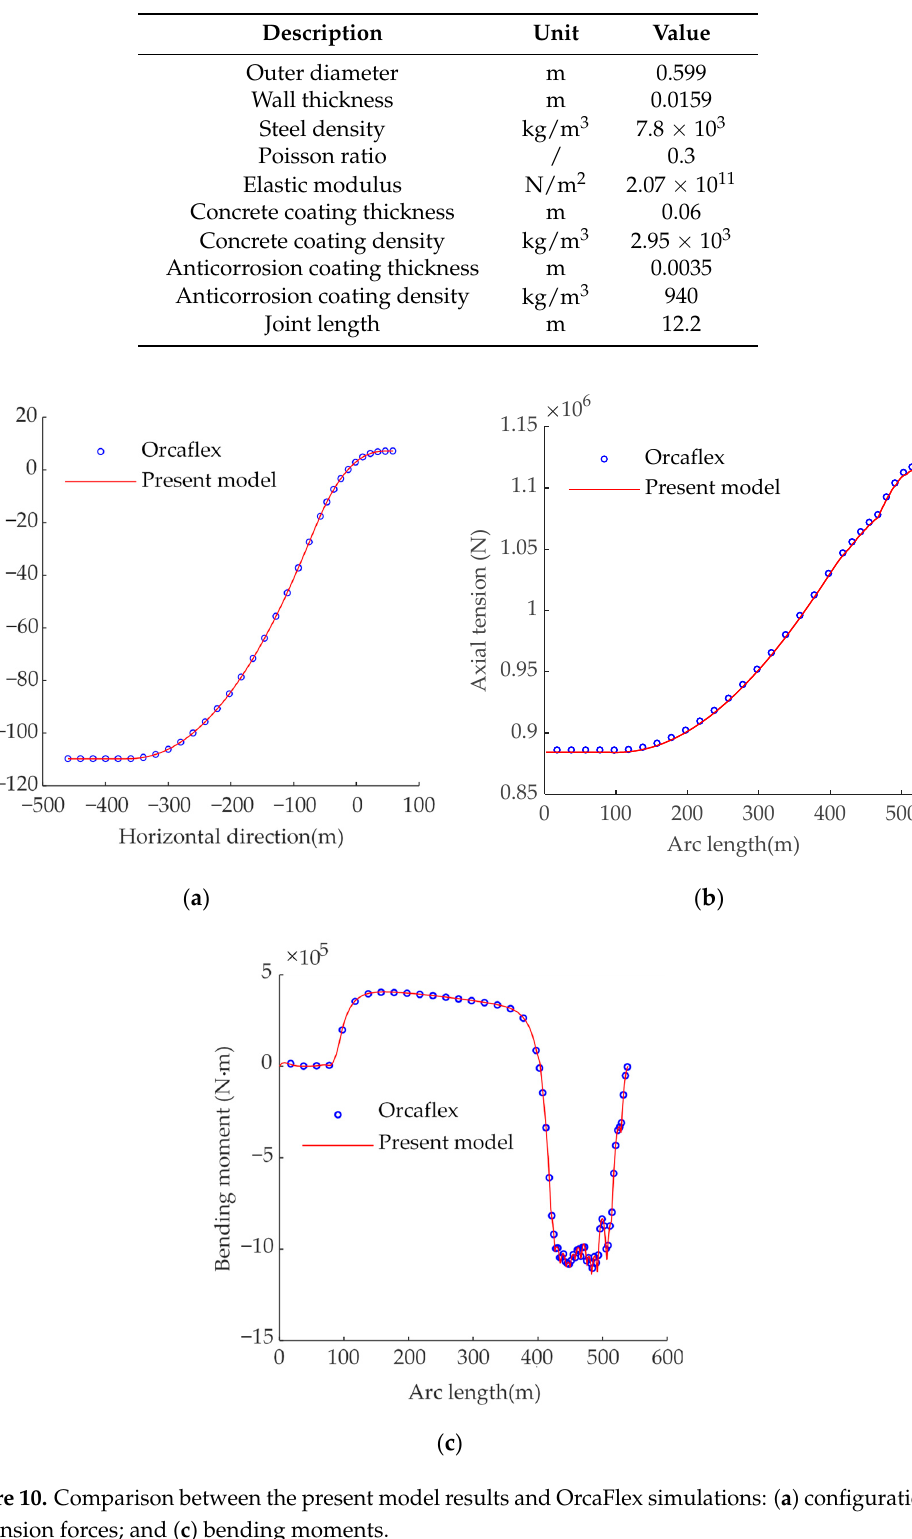
45 Figure 11. The variation of the current velocity at different water depths.